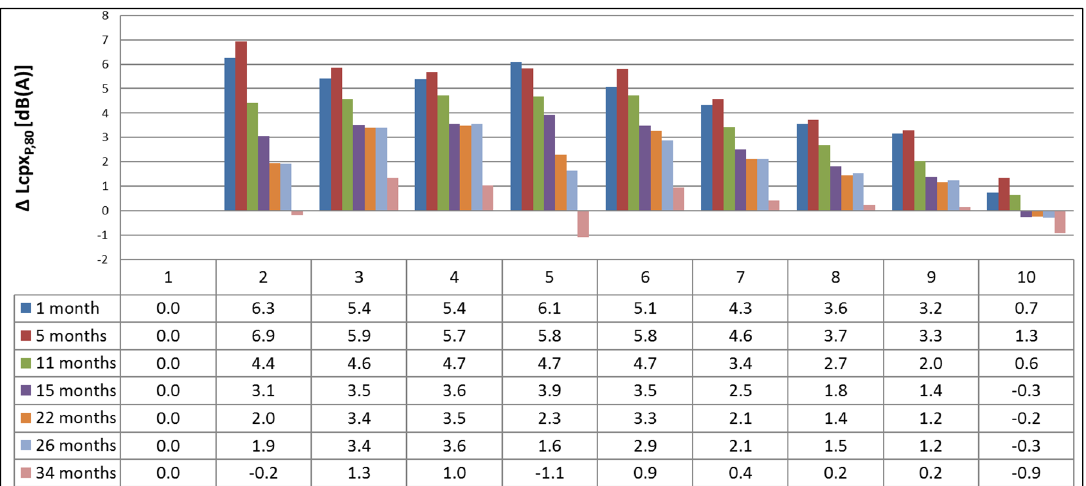
Figure 7. Overview of the noise reduction, based on the CPX results (P1 tire) with temperature correction, 1, 5, 11, 15, 22, 26 and 34 months after construction compared to the SMA ‐ 10 as a reference road surface at the same time interval.